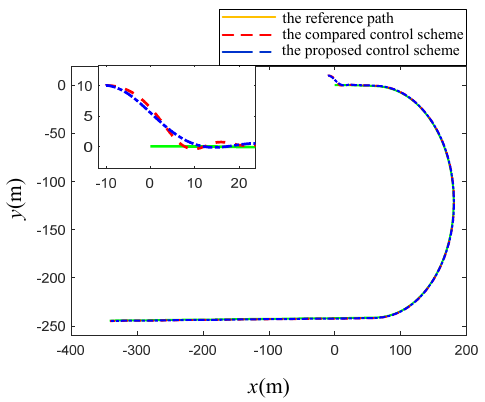
 and  for ASVs. u r